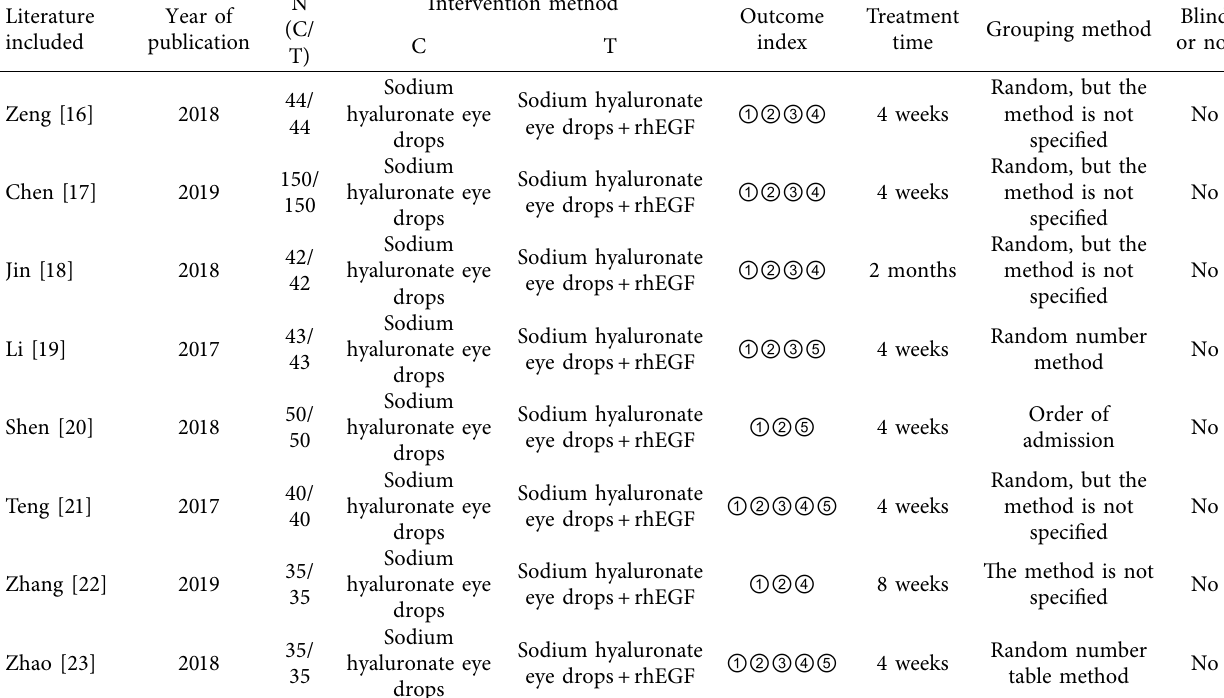
Table 1: Basic characteristics of literature.